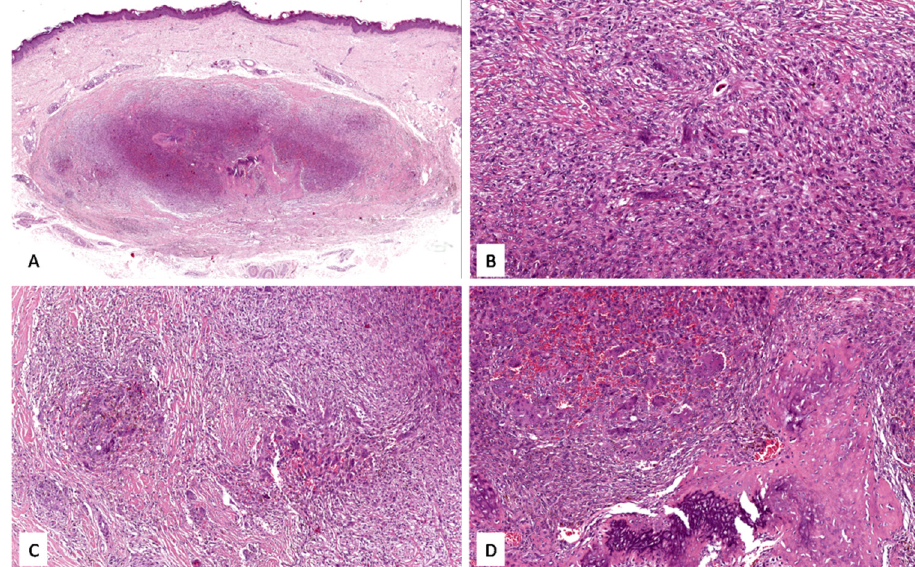
Figure 1. ( A ) Low magnification showing a dermal-based, hypercellular lesion with well-defined borders (hematoxylin and eosin; original magnification 40 × ); ( B ) lesion is composed of spindled to ovoid cells with eosinophilic and foamy cytoplasm and nuclei with dispersed chromatin, inter- mingled with scattered multinucleated osteoclast-like giant cells (hematoxylin and eosin; original magnification 200 × ); ( C ) a multinodular growth pattern is seen (hematoxylin and eosin; original magnification 100 × ); ( D ) lesion exhibits, as a peculiar feature, multiple islands of mature metaplastic bone tissue rimmed by abundant multinucleated osteoclast-like giant cells. Numerous extravasated red blood cells are also present (hematoxylin and eosin; original magnification 100 ×